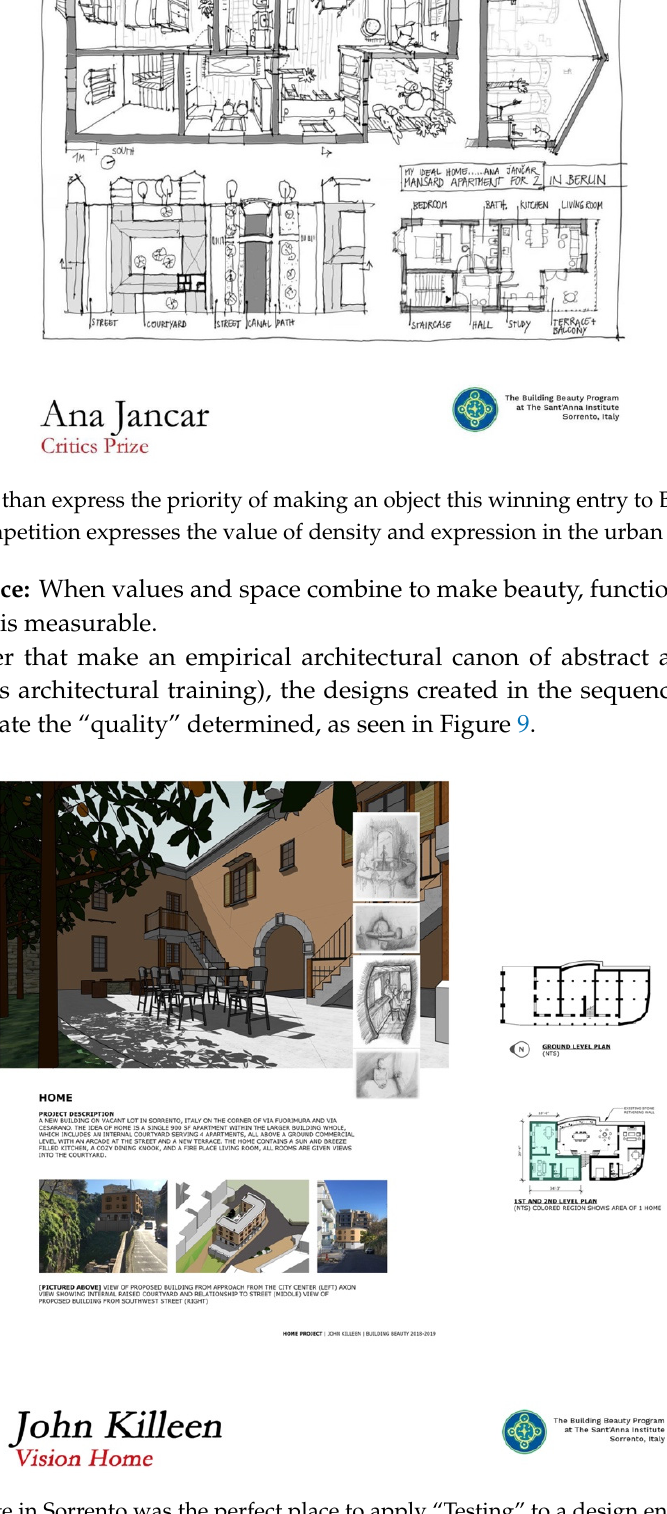
Figure 9. This site in Sorrento was the perfect place to apply “Testing” to a design entry in the HOME competition at Building Beauty in 2019.